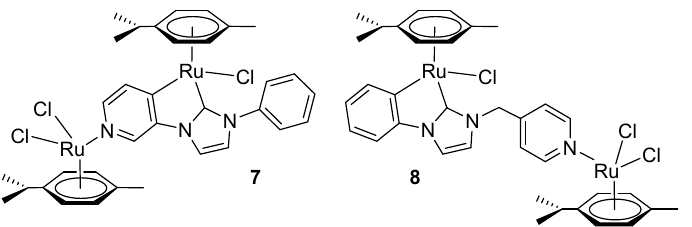
Figure 1. Bimetallic complexes 7 and 8 bearing a CC -cyclometalated NHC-pyridyl or NHC-phenyl ligand. Monometallic complexes bearing closely related CC -cycloruthenated NHC-phenyl ligands were then successively described by the groups of Ramesh [16] and Rit [17], and